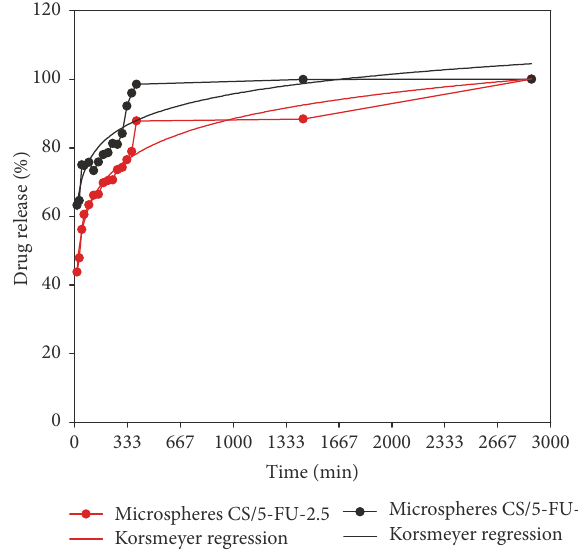
Figure 6: Liberation profile of 5-FU from microspheres in PBS of pH